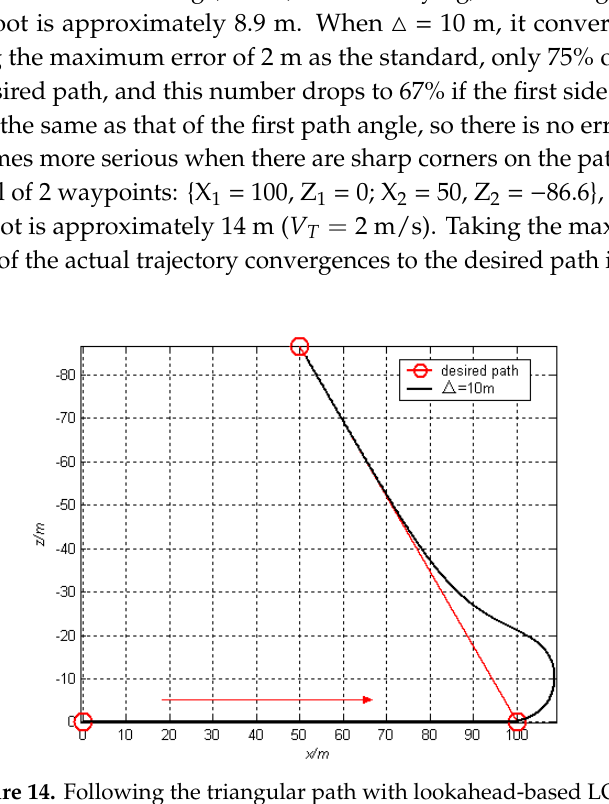
Figure 13. Following the square path with lookahead-based LOS.